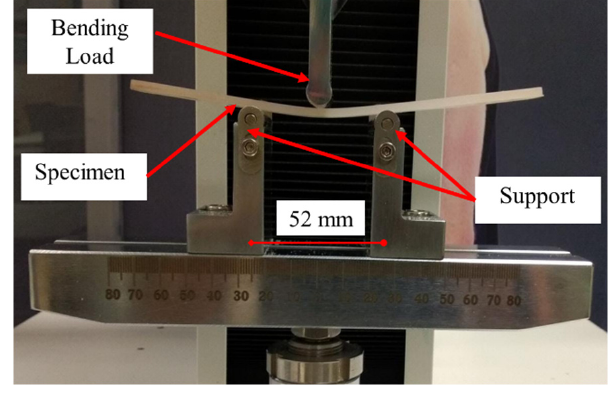
Figure 4. Three-point bending testing.